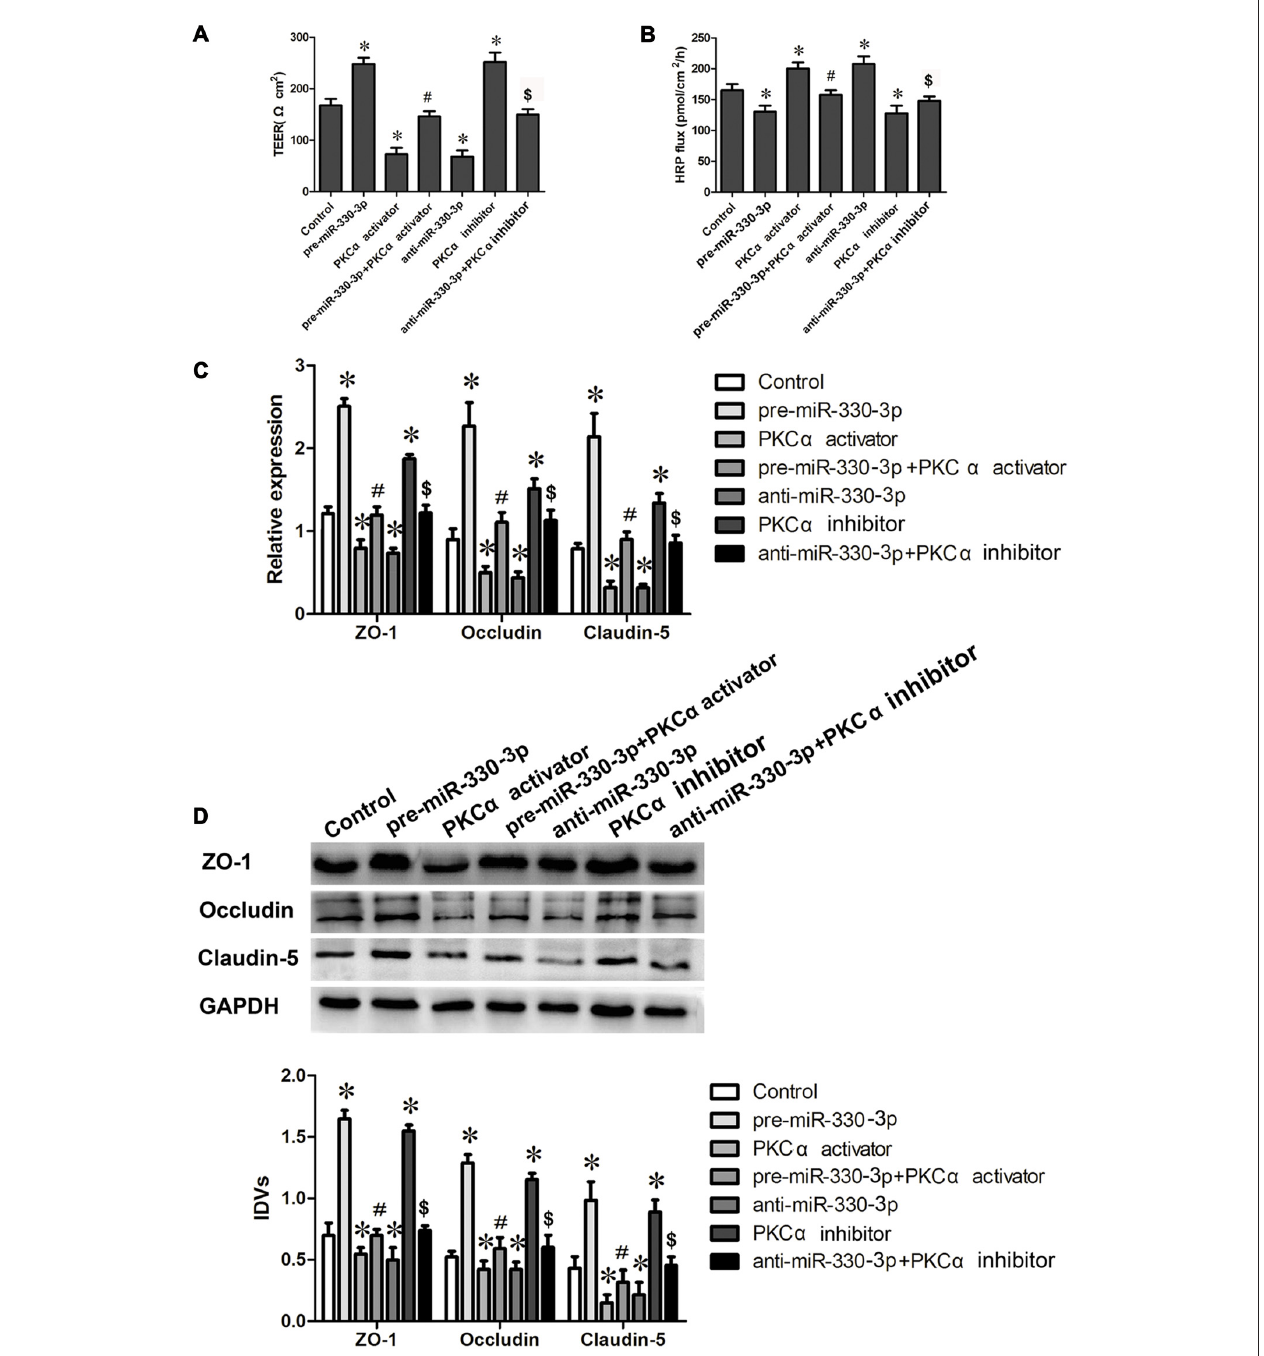
FIGURE 5 | MiR-330-3p combined with PKC α activator or PKC α inhibitor affect BTB permeability and the expression levels of TJ related proteins. (A,B) TEER and HRP assays were used to measure the permeability of BTB. (C) The relative mRNA expression levels of ZO-1, occludin, and claudin-5 were detected by real-time quantitative PCR. U6 was used as an inner control. (D) The protein expression levels of ZO-1, occludin and claudin-5 were determined by Western blot. GAPDH was used as an inner control. Values are means ± SD ( n = 5, each). ∗ P < 0.05 vs. control group; # P < 0.05 vs. pre-miR-330-3p group; $ P < 0.05 vs. anti-miR-330-3p